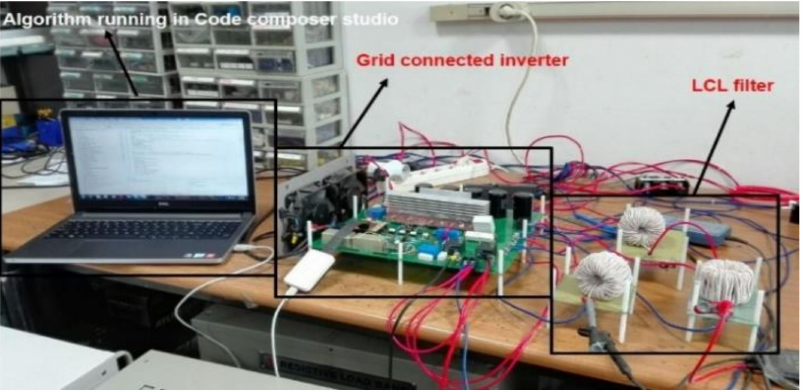
Figure 11. Experimental setup of a 5 kW single phase GCI.